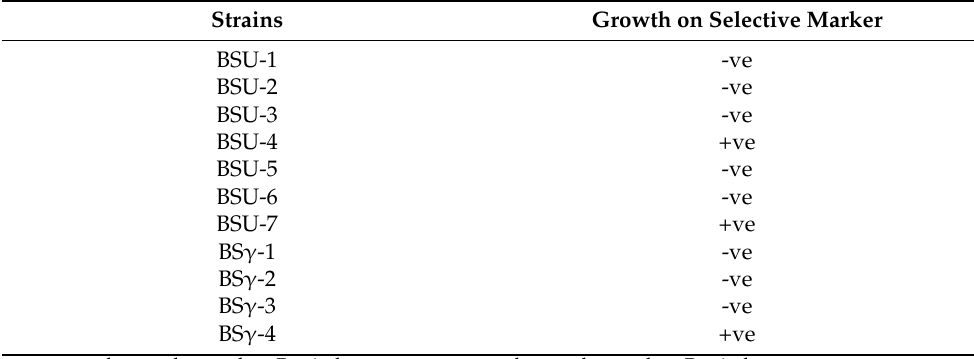
Table 1. Selection of best mutants on the selective marker.